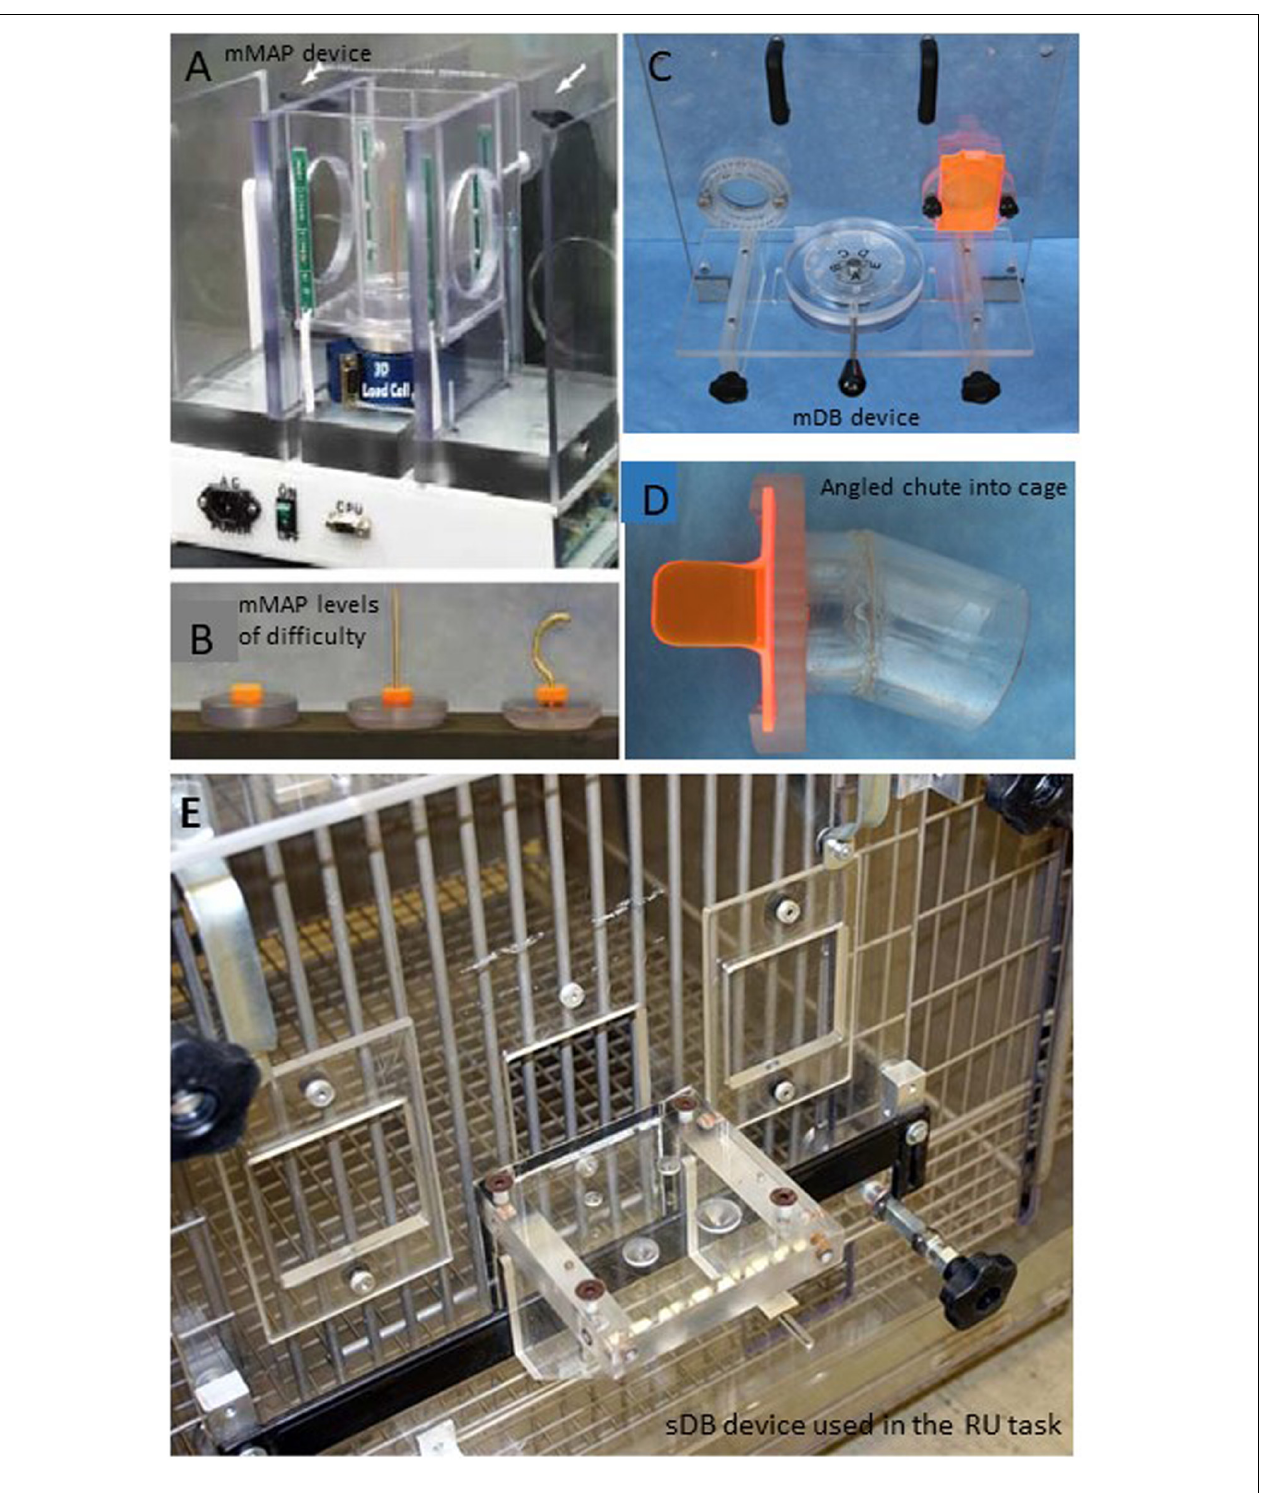
FIGURE 3 | Pictures of the devices used to measure upper limb motor function. The modified movement assessment panel is shown in panel (A) with the different levels of difficulty shown below in panel (B) . The modified dexterity board is shown in panel (C) with the angled chute into the cage that the monkey has to move the hand through to reach to the food target. The angled chute constrains which hand can be used to successfully reach to the food target (D) . The standard dexterity board used in the pre-lesion handedness test and the post-lesion reduced use tests when the animals can choose which hand to use is shown in panel (E) .